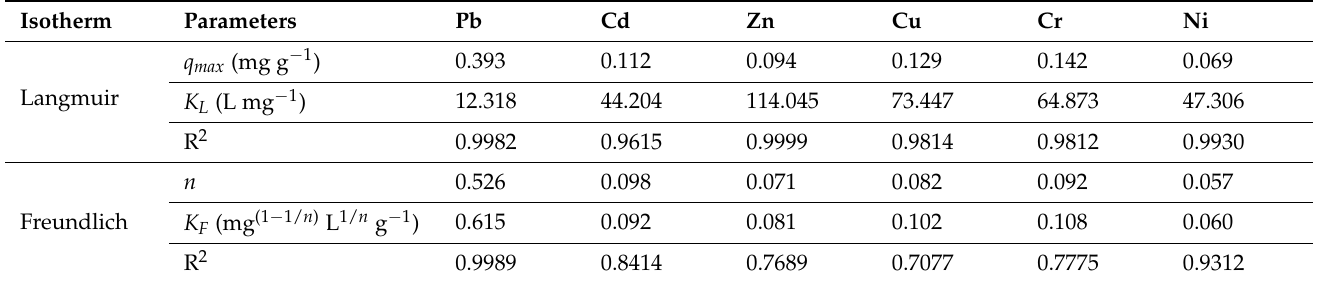
Table 4. Langmuir and Freundlich isotherm parameters for Pb, Cd, Zn, Cu, Cr, and Ni ions sorption onto zeolite with a 0–0.05 mm particle size thermally treated at 200 ◦